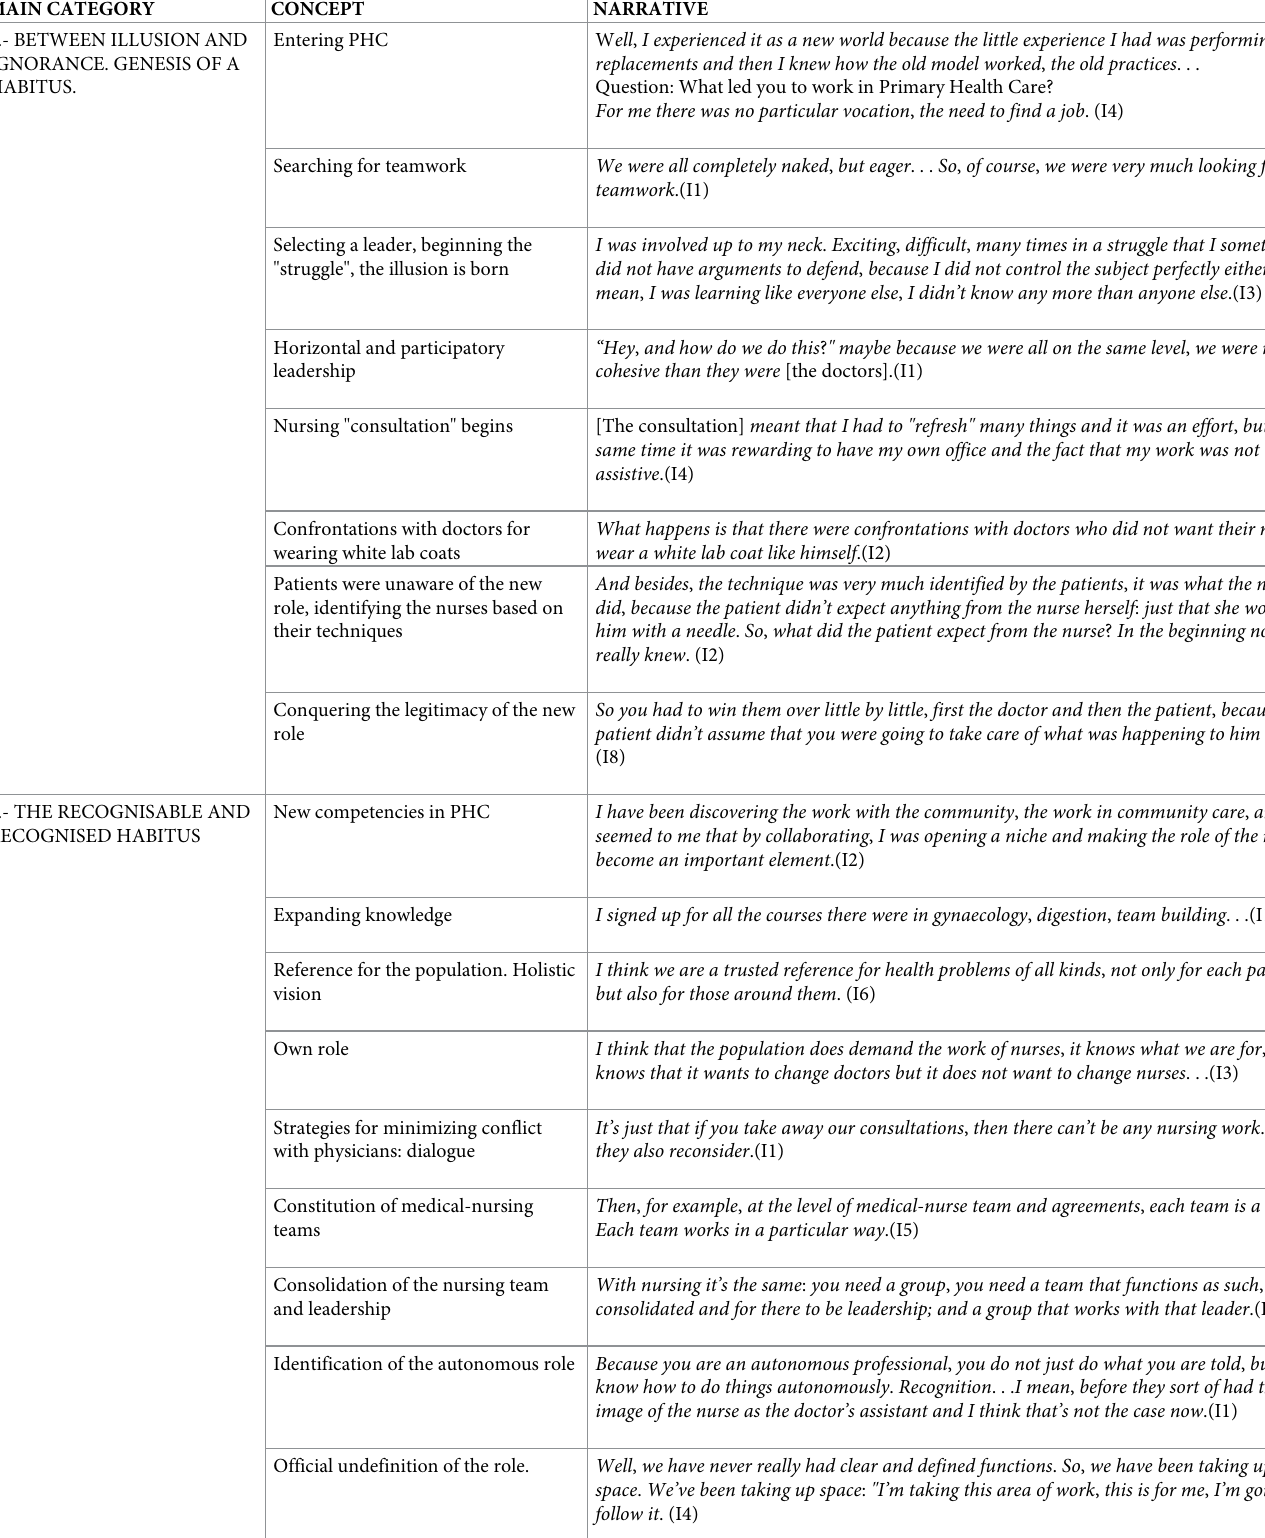
Table 3. Additional participant